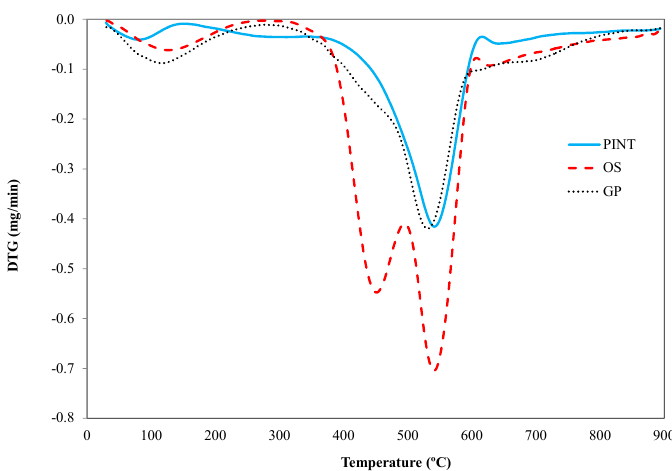
Figure 5. Combustion profiles, expressed as the derivative thermogravimetric (DTG) of the samples.